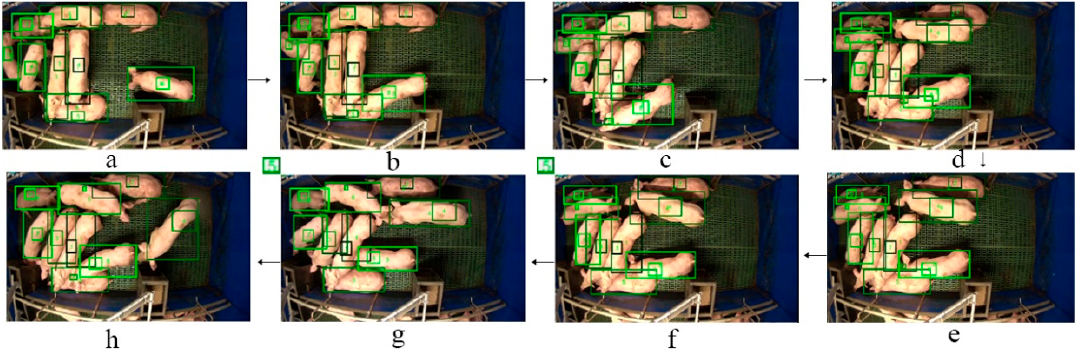
Figure 9. The example detection and tracking results of our method in day video with a severe occlusion related to the pigs overlapping. The sequence order is from frame ( a ) to ( h ).